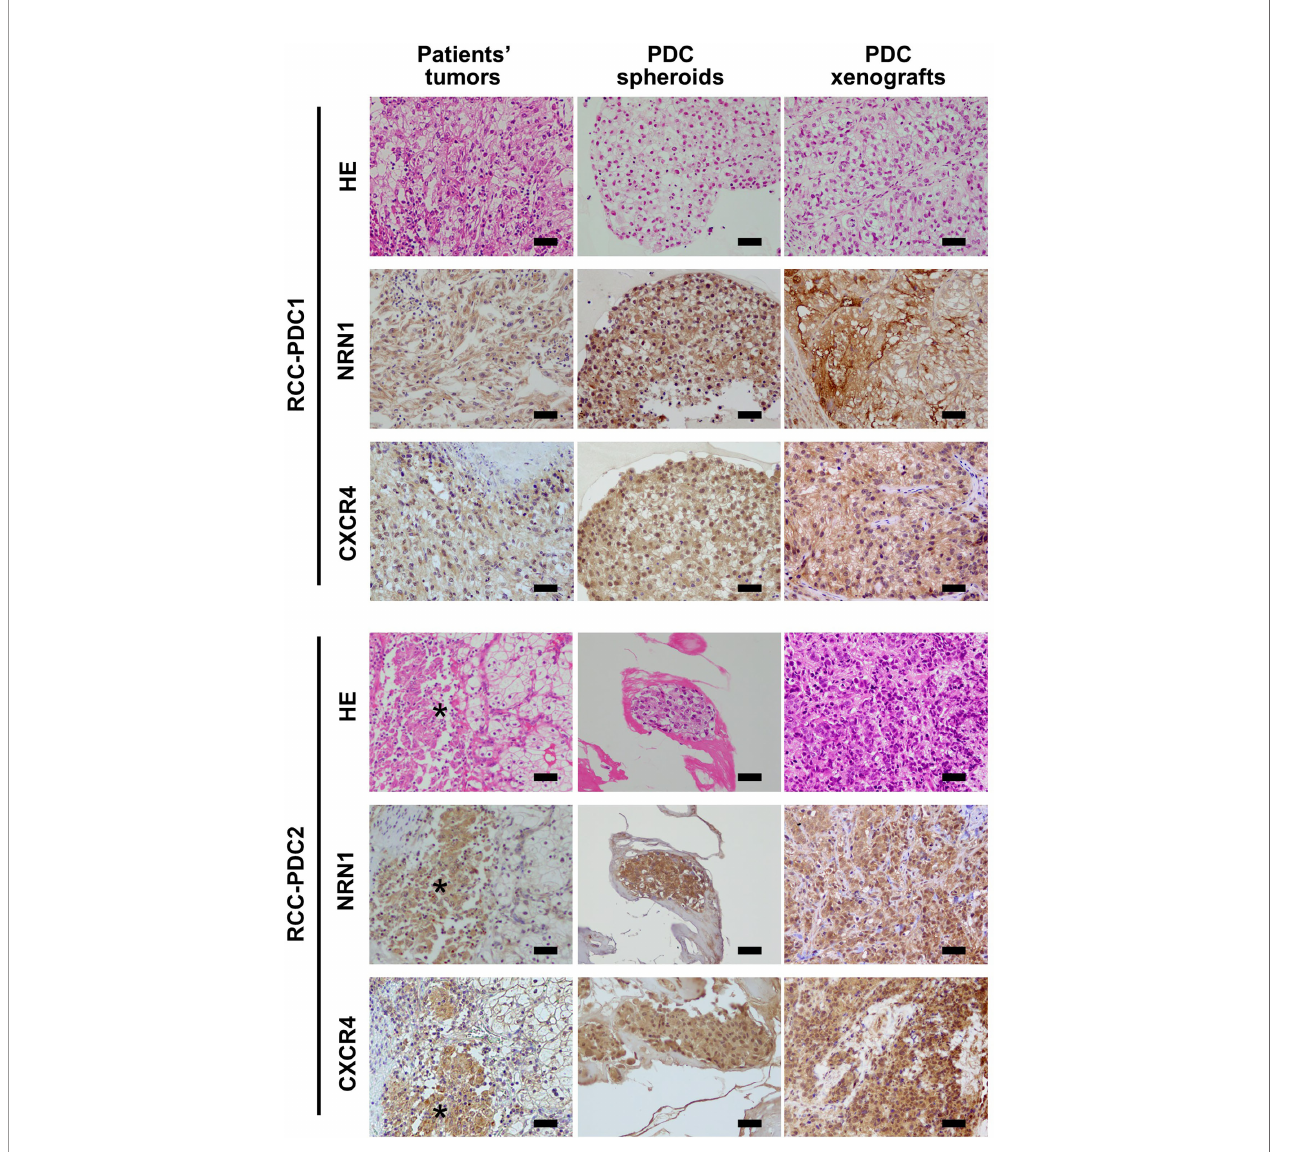
FIGURE 2 | Histological analysis of RCC primary tumors, and their patient-derived cancer models. Hematoxylin and eosin (HE) staining, NRN1 and CXCR4 immunohistochemistry of primary tumor specimens, corresponding patient-derived cancer cell (PDC) spheroid cultures, and their xenograft tumors. Star represents ccRCC tumor portion with eosinophilic cytoplasm. Scale bars, 50